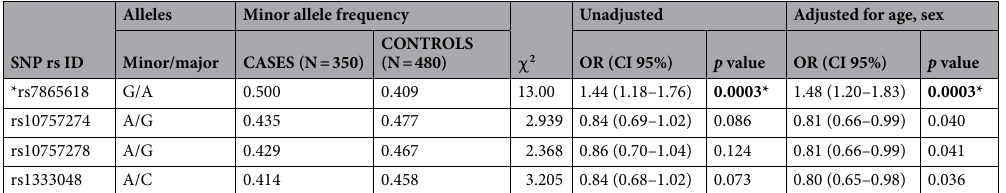
Table 1. Allelic association of SNP variants at 9p21.3 chromosomal region with CAD. *SNP significant after multiple correction (p_corrected = 0.008). Bold indicates the significant p value.